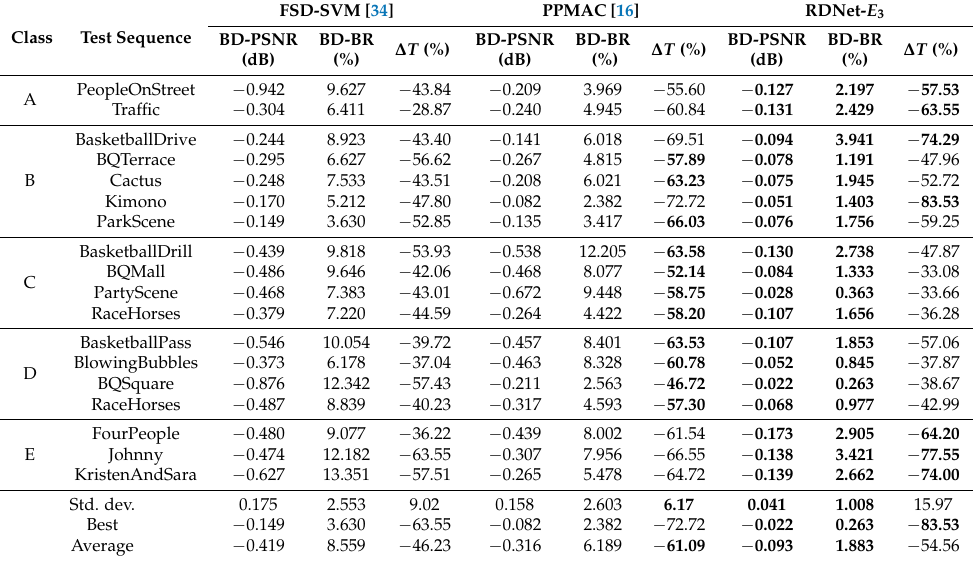
Table 4. Performance comparison with state-of-the-art approaches used the same